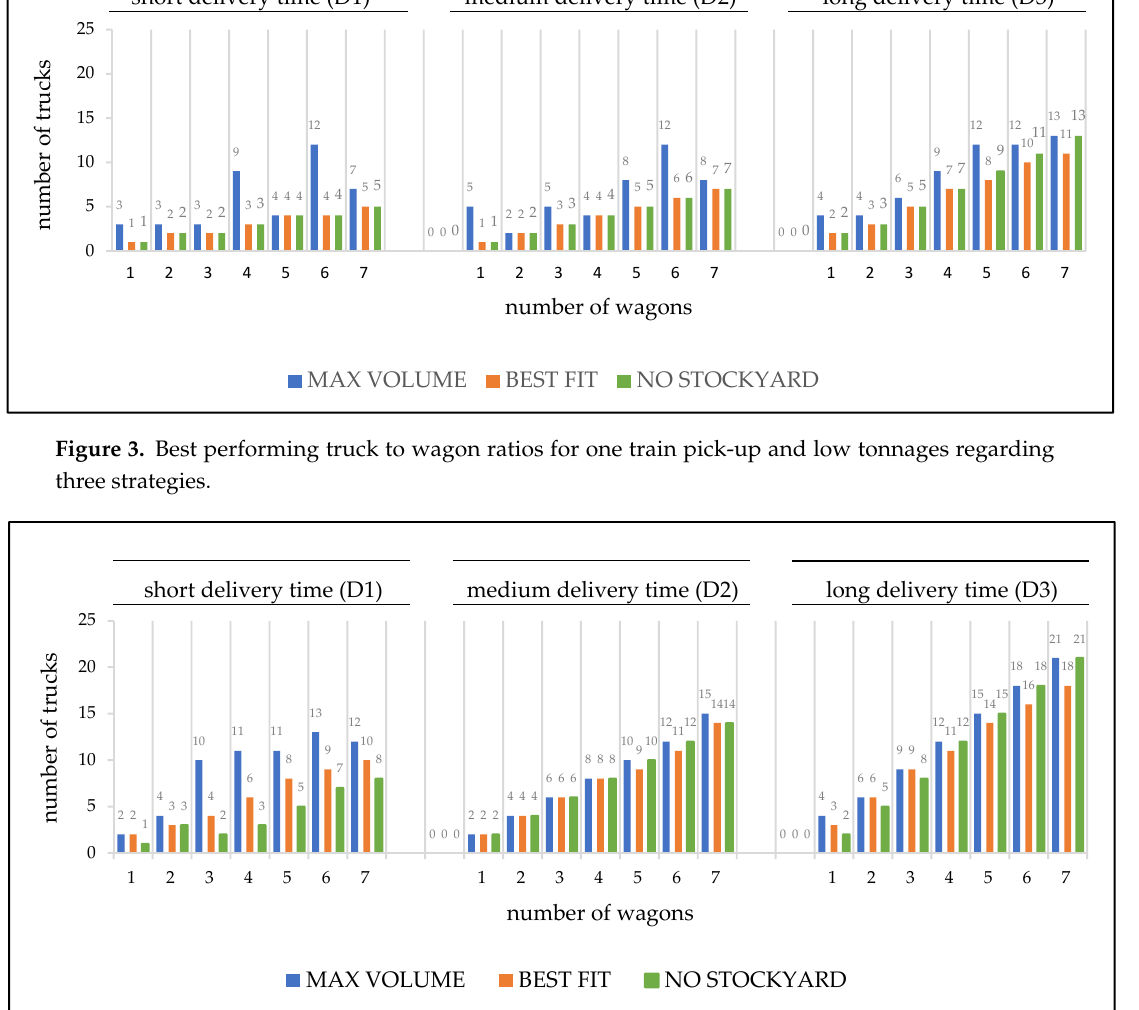
Figure 4. Best performing truck to truck ratios for two train pick ‐ ups and low tonnages regarding three strategies.